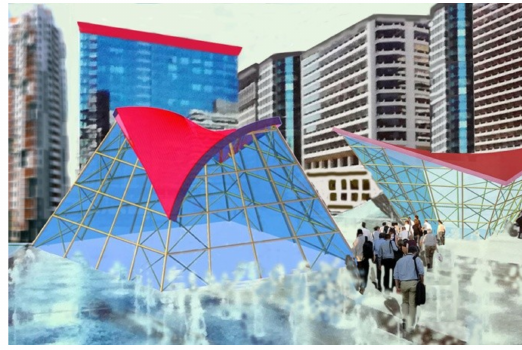
Figure 29. Two free-form buildings roofed with transformed shells located in a built